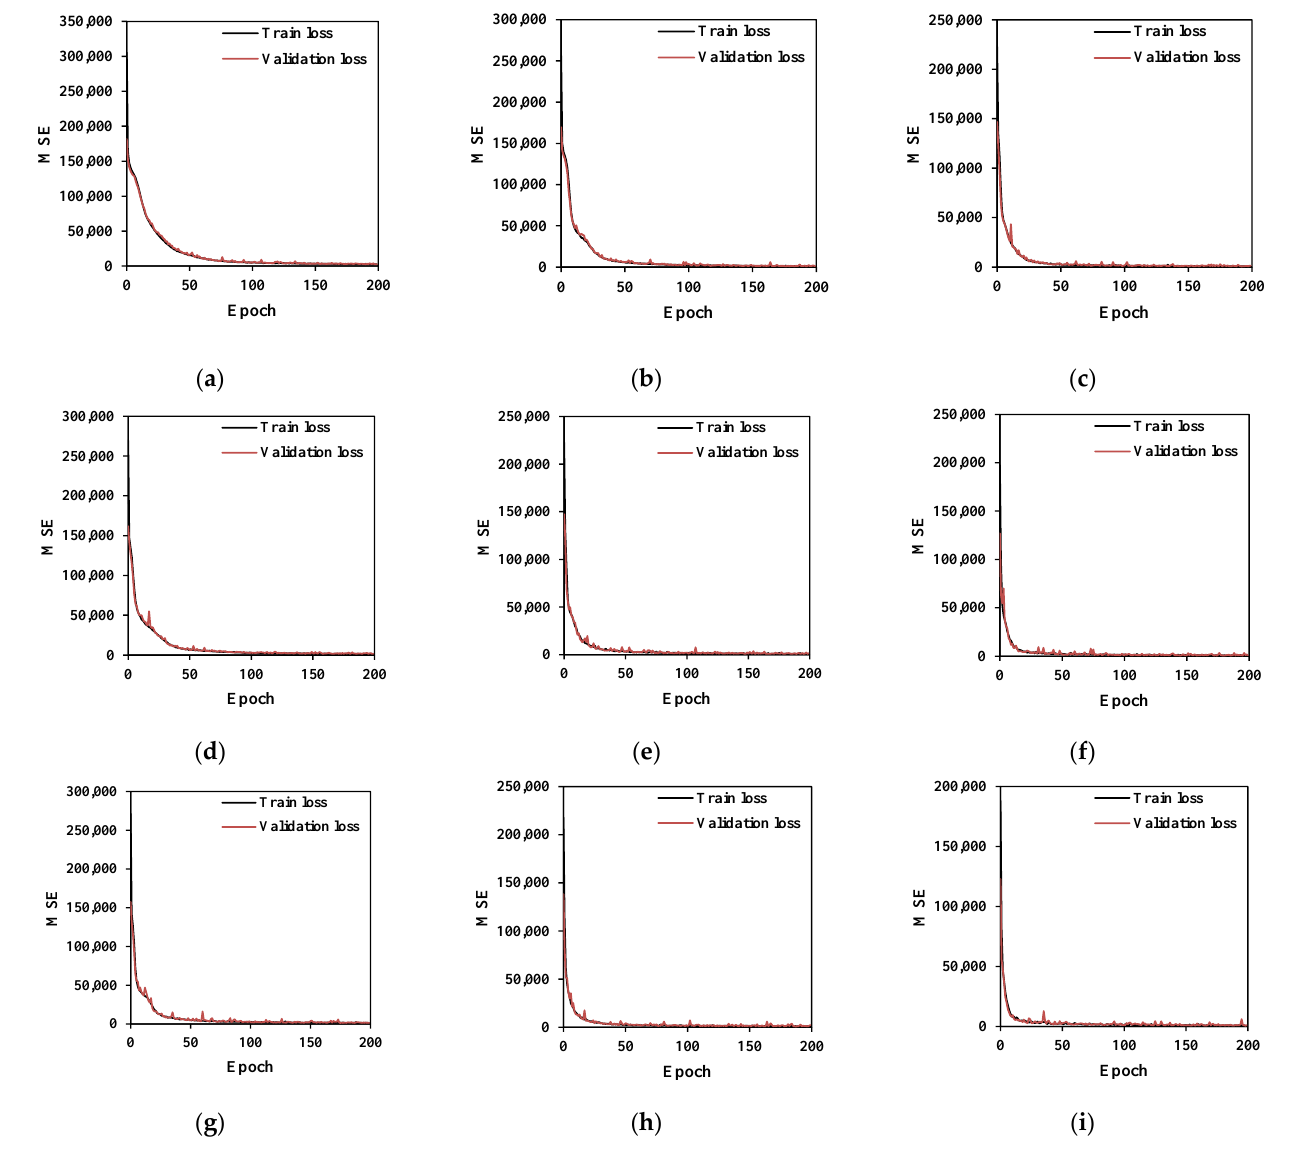
Figure 12. Comparisons of training and validation loss of bracing forces ( 𝐹 𝑏𝑟 ): ( a ) 3-50-200; ( b ) 3- 100-200; ( c ) 3-200-200; ( d ) 4-50-200; ( e ) 4-100-200; ( f ) 4-200-200; ( g ) 5-50-200; ( h ) 5-100-200; and ( i ) 5-200-200 (in which 3-50-200 means a DNN model with 3 hidden layers, 50 neurons for each hidden layer, and 200 epochs). Table 10. Accuracy of DNN models for 𝐹 𝑏𝑟 using various performance criteria. Hidden Model